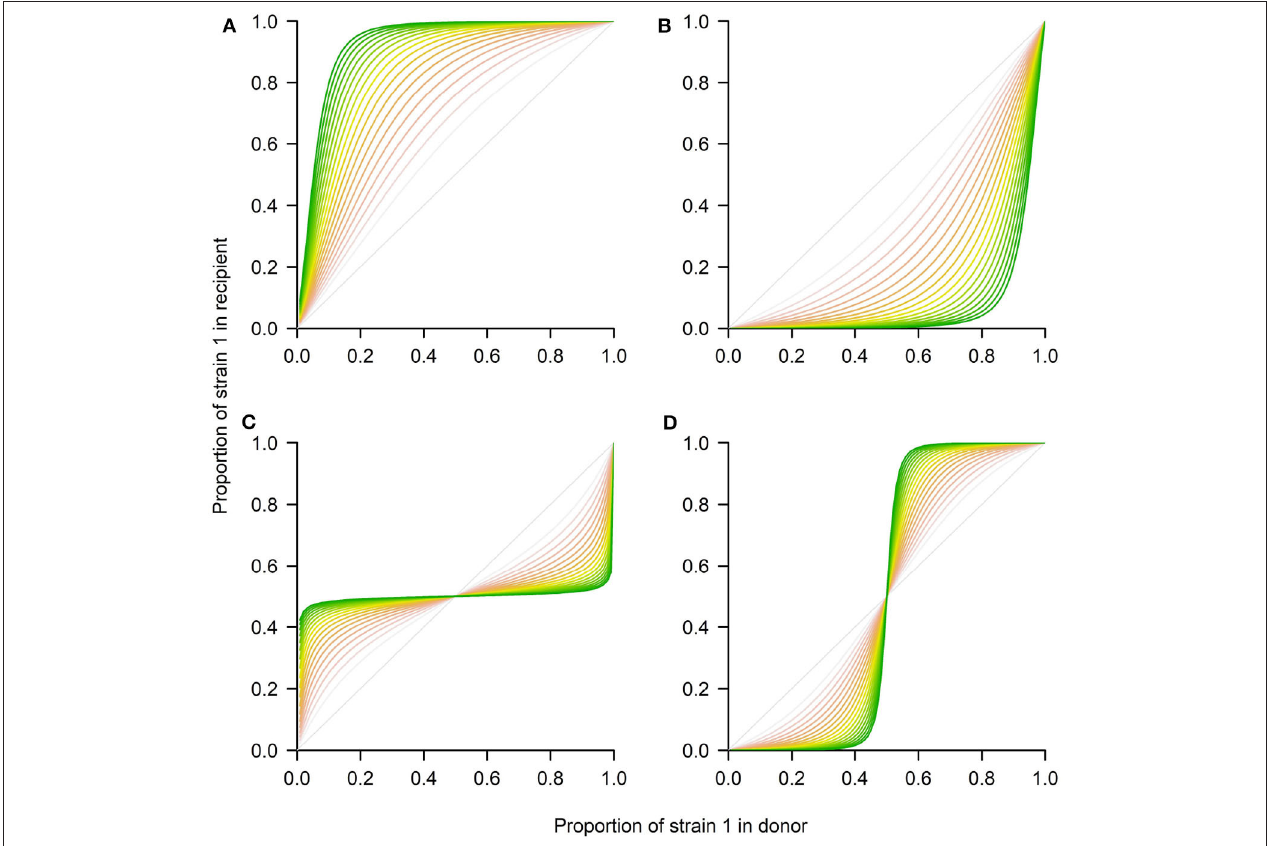
FIGURE 3 | Four possible outcomes between 2 strains in transmission using the Lotka-Volterra model. The system of Equations 4–5 was numerically integrated using the deSolve package in R to represent the four ecological scenarios in terms of p 1 ( τ ) in the recipient. (A) Competitive exclusion where the mutant wins (strain 1). (B) Competitive exclusion where the WT wins (strain 2). (C) Coexistence between strains. (D) Bistability, where mutant or WT may win, depending on initial frequency. The different shading from red to green corresponds to later time-points over the donor-to-recipient dynamics ( τ ∈ [0,20]). As time increases, the system tends to approach more closely the equilibrium. Parameters values: (A) ρ = 1, a 12 = 0.9, a 21 = 1.3, β = 1. (B) ρ = 1, a 12 = 1.3, a 21 = 0.9, β = 1. (C) ρ = 1, a 12 = 0.7, a 21 = 0.7, β = 1. (D) ρ = 1, a 12 = 1.3, a 21 = 1.3, β =